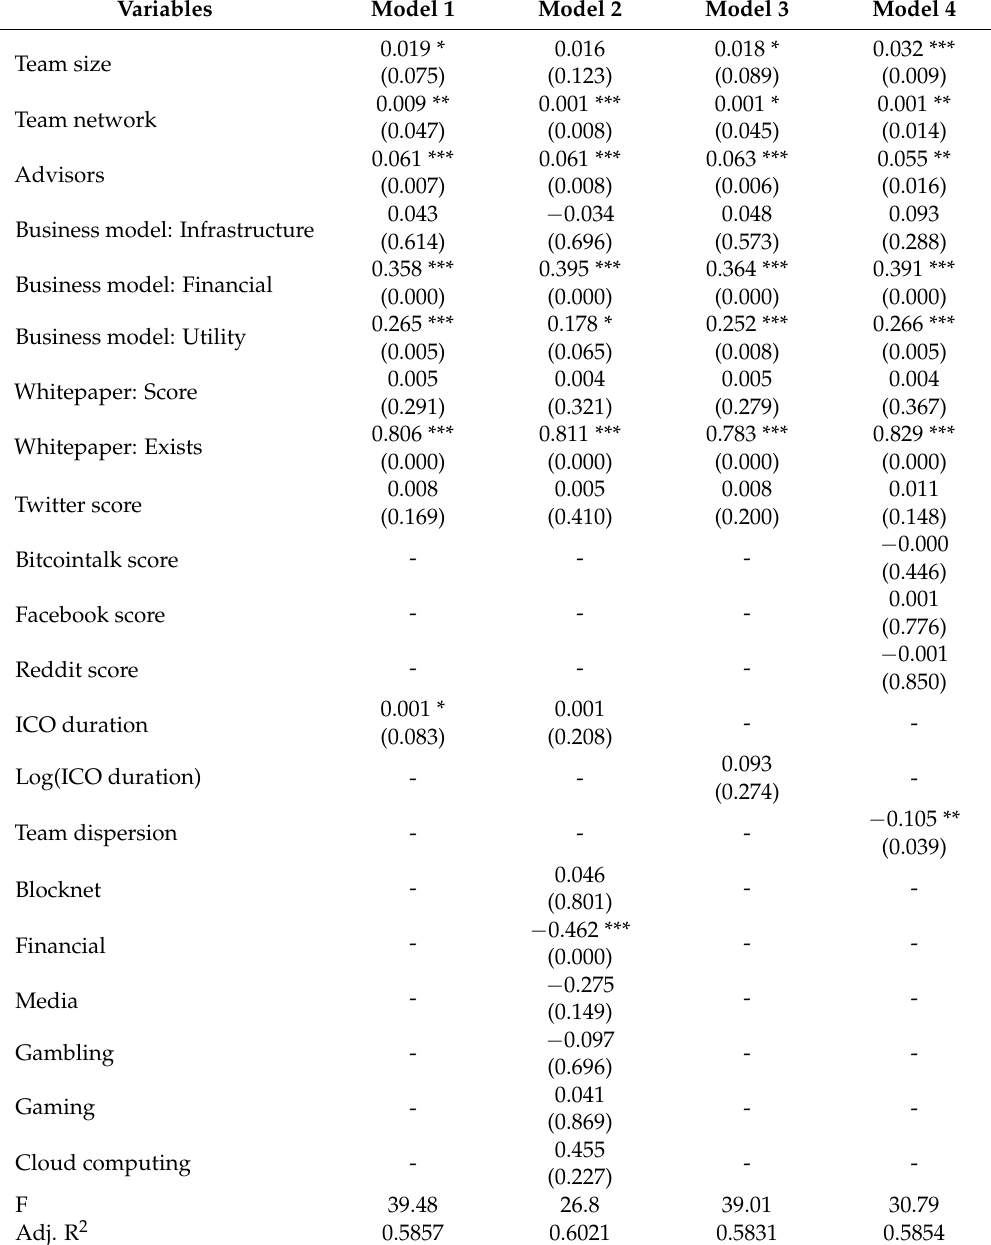
Table 2. Results of OLS regression